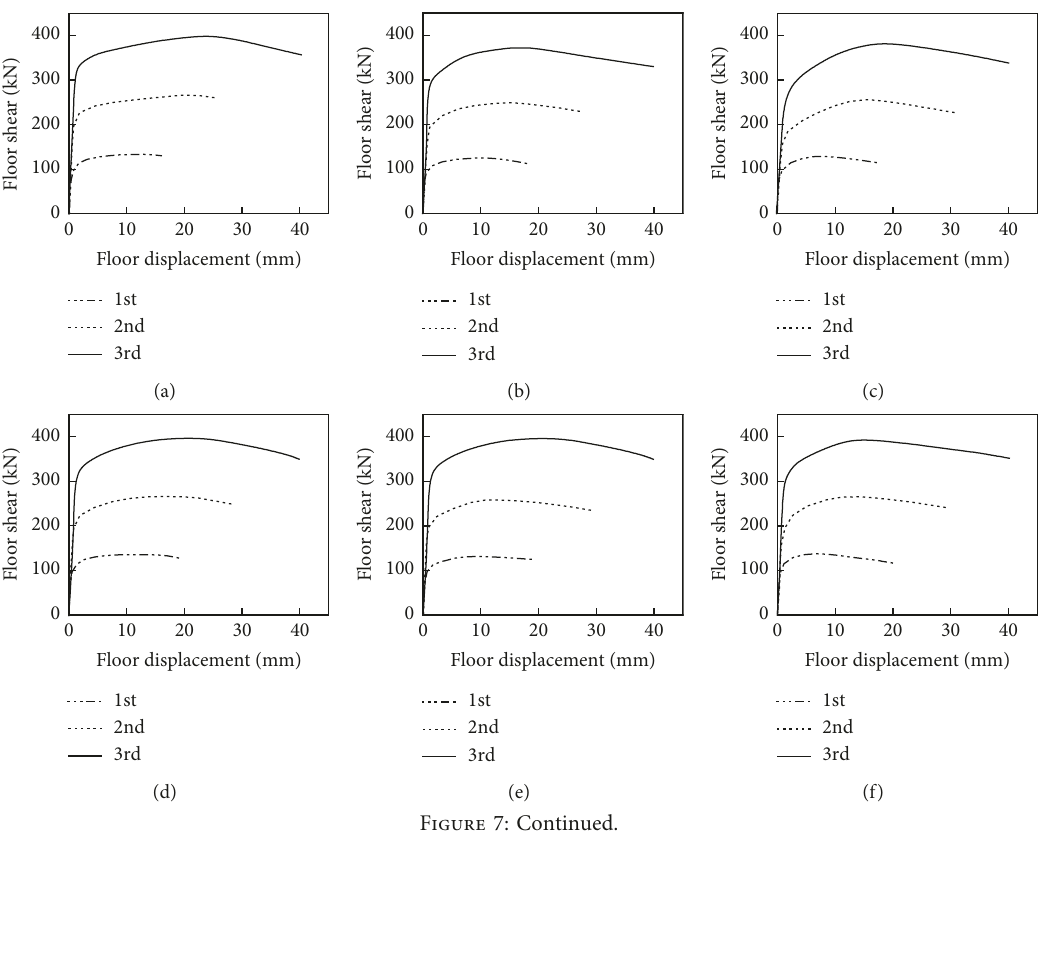
MaS4-7 (0.1g) . (a) Intact structure model. (b) Dem 1|2&3/A-B. (c) Dem < >